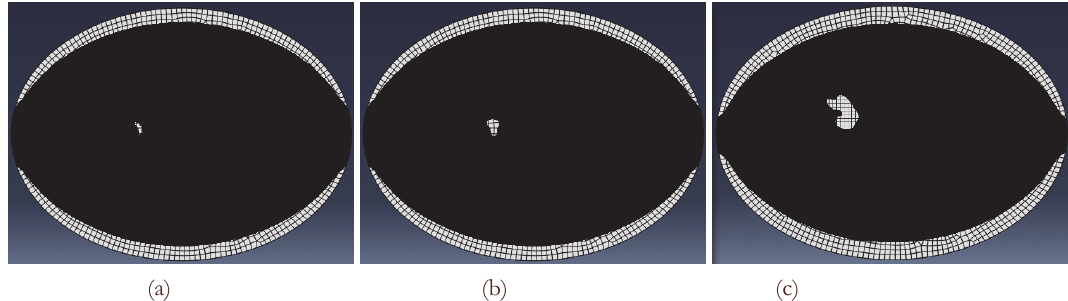
Figure 10: Damaged zone for a circular patch (a) θ = 15 o , (b) θ = 45 o and (c) θ = 75 o .